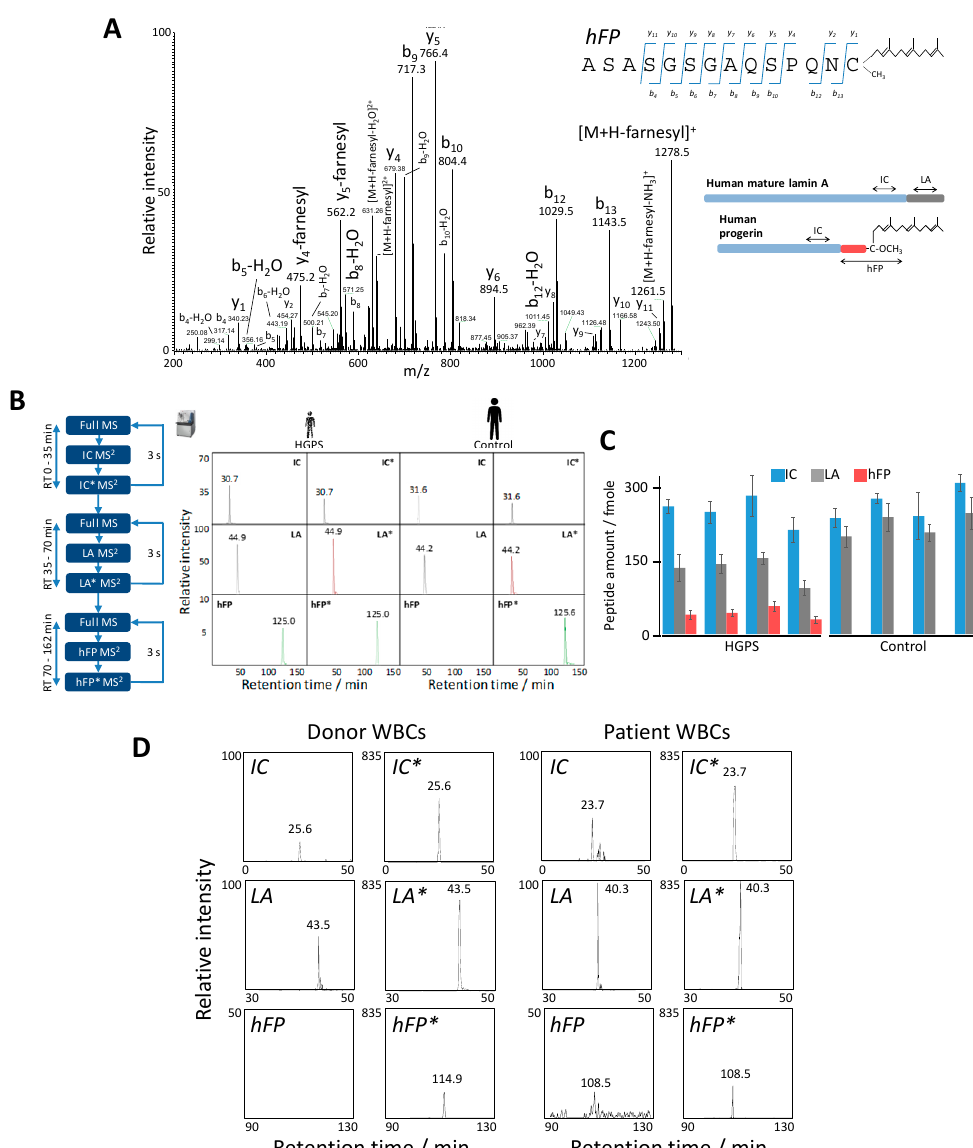
Figure 6. Absolute quantification of human progerin by parallel reaction monitoring (PRM) analysis. ( A ) Representative MS 2 fragmentation spectrum of the endogenous, farnesylated hFP peptide ob- tained in the PRM assay (see scheme) from skin fibroblasts of Hutchinson-Gilford progeria syndrome (HGPS) patients. The inset shows the ion ascription to the main fragment-ion series (C-terminal y-series and N-terminal b-series). ( B ) Representative MS 2 XICs of endogenous IC , LA , and hFP (see scheme in ( A )) and the isotope-labeled, spiked-in peptides IC* , LA* , and hFP* obtained in the time-scheduled PRM assay with human HGPS and control skin fibroblasts for the absolute quan- tification of lamin A and progerin (see Table 3 for details). ( C ) Absolute quantification of surrogate peptides IC , LA , and hFP in four human HGPS and four control fibroblast samples. Error bars indicate standard deviation for triplicate analysis. ( D ) MS 2 XICs of surrogate peptides IC , LA , hFP , and the isotope-labeled, spiked-in peptides IC* , LA* , and hFP* measured in the PRM assay with WBCs from a healthy donor (Left) and an HGPS patient (Right). Relative intensities were normalized to that of endogenous peptide LA , which was assigned an arbitrary intensity of 100 in the patient sample, except for the hFP peptide, which was scaled to 50. Retention time deviations between donor and patient are due to the use of different chromatographic columns (see Supplementary